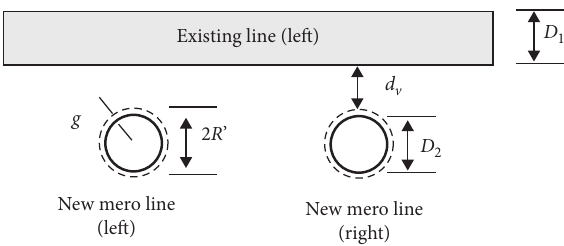
Figure 13: Cross section of the new tunnel and the existing tunnel.